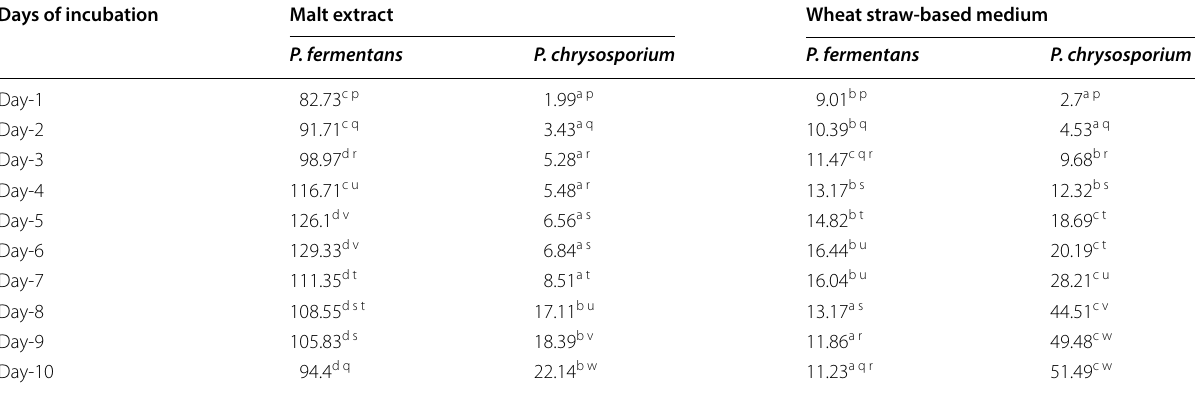
Similar superscripts (a, b, c, d) show no statistically significant difference (P > 0.05) within each row, while similar superscripts (p, q, r s, t, u, v, w) show no statistically significant difference ( P > 0.05) within each column